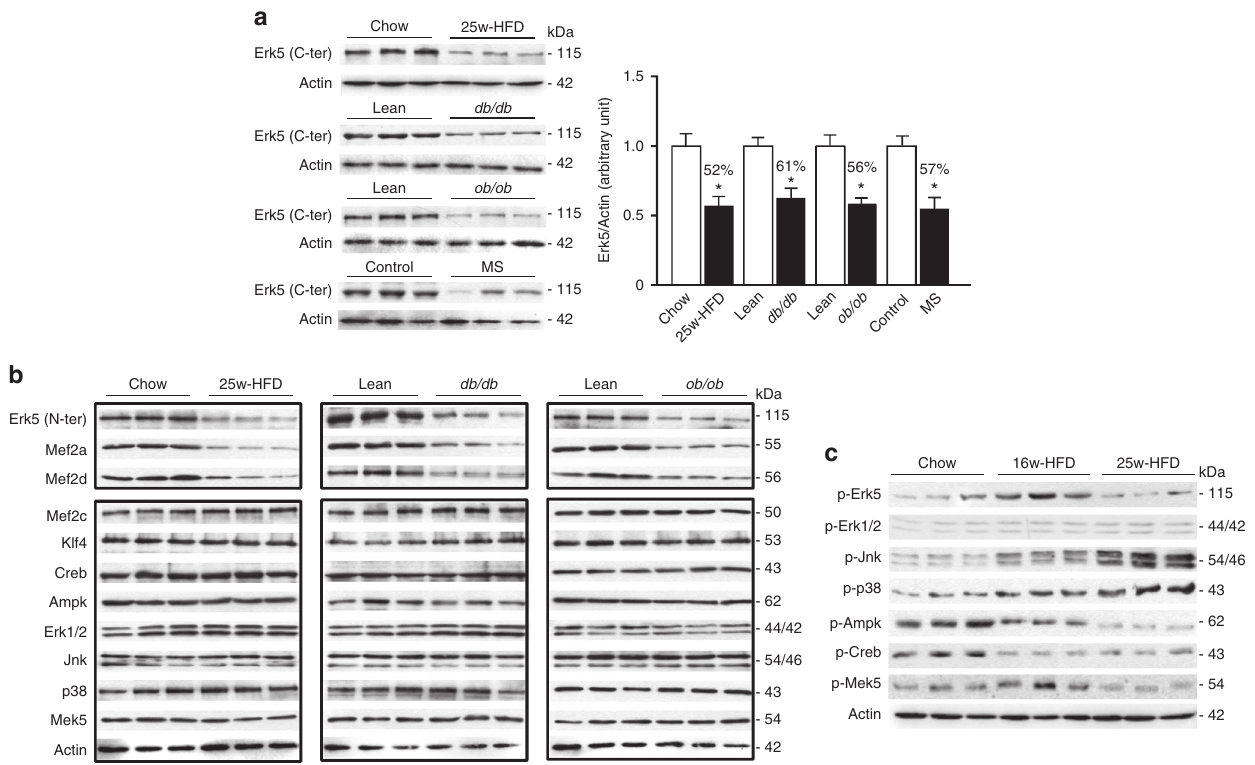
Fig. 1 Decreased expression and phosphorylation of Erk5 in the obesity/diabetic hearts. a Immunoblot analyses (antibody recognizing C-terminus of Erk5) showed a decrease of Erk5 expression in the hearts from C57BL/6J mice with 25-week HFD, db/db mice, ob/ob mice, or rhesus monkeys with metabolic syndrome (MS). Quanti fi cation of Erk5/Actin ratio is presented in the bar graph. Data are means ± SD (* P < 0.05, vs. control groups, n = 6 animals per group). b Immunoblot analyses substantiated that expression level of Erk5 (antibody recognizing N-terminus of Erk5), Mef2a and Mef2d was decreased in the obesity/diabetic hearts. c The phosphorylation levels of Erk5, Erk1/2, Jnk, p38, Ampk, Creb, and Mek5 in the hearts from mice with 16-week or 25-week HFD were examined by immunoblot analyses. Actin is the protein loading